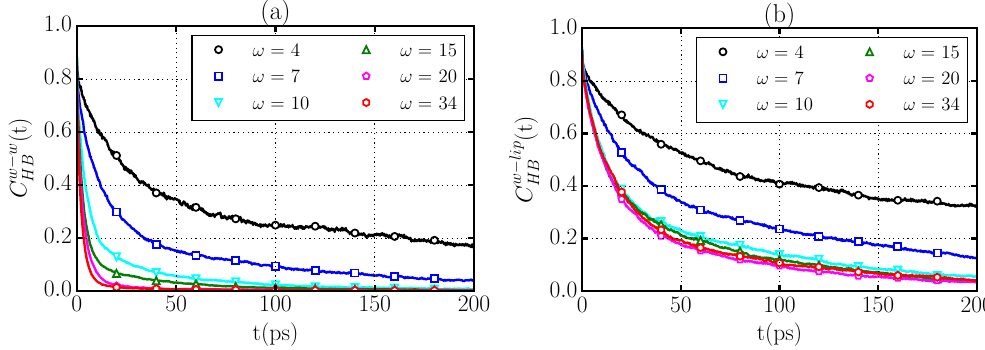
( t ) ( a ) and C w − l ( t ) ( b ) for stacked HB HB